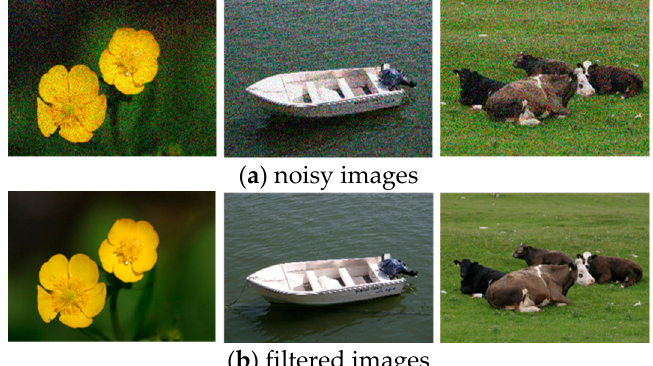
Figure 2. Some preprocessing steps include, ( a ) depicting noisy images and ( b ) filtering noise on images over the MSRC dataset.